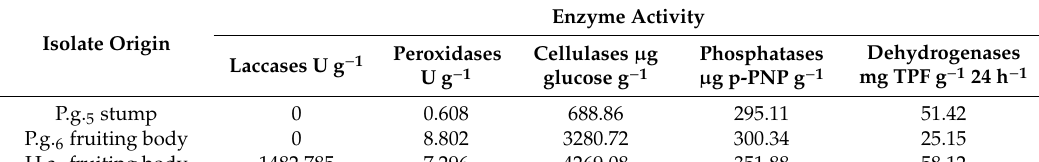
Table 1. Average enzymatic activity of isolates of P. gigantea and H. annosum mycelium growing on Scots pine wood, calculated on dry wood mass basis (data modified from Ż ó ł ciak et al. [76]).